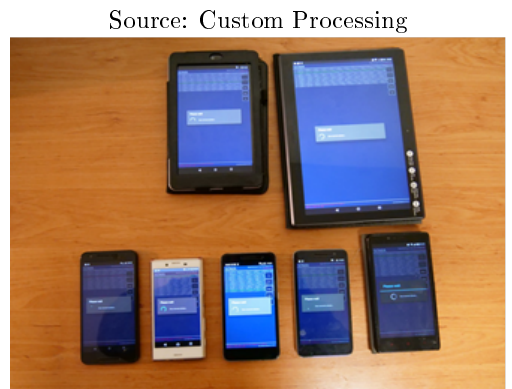
Fig. 7: a common solution with method All To One Net Adaptive Source: Custom Processing - Photo- graph of used